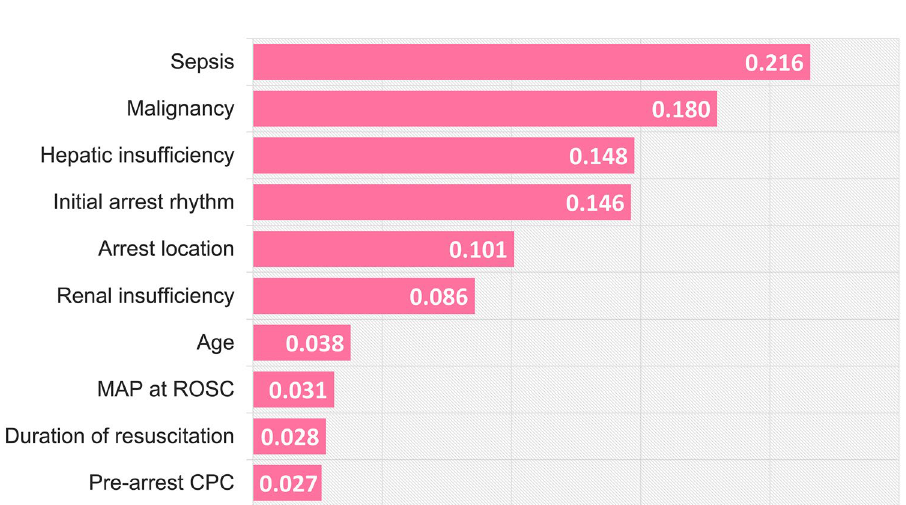
Figure 4. Significance of variables in the ANN model. Graphical representation of the relative significance of the individual parameters in the ANN model. The numbers in each color-coded bar indicate the calculated indices of the total effect of the predicting factors, with a higher value representing a greater significance attributed to the model. ANN artificial neural network, CPC cerebral performance category, MAP mean arterial pressure, ROSC restoration of spontaneous